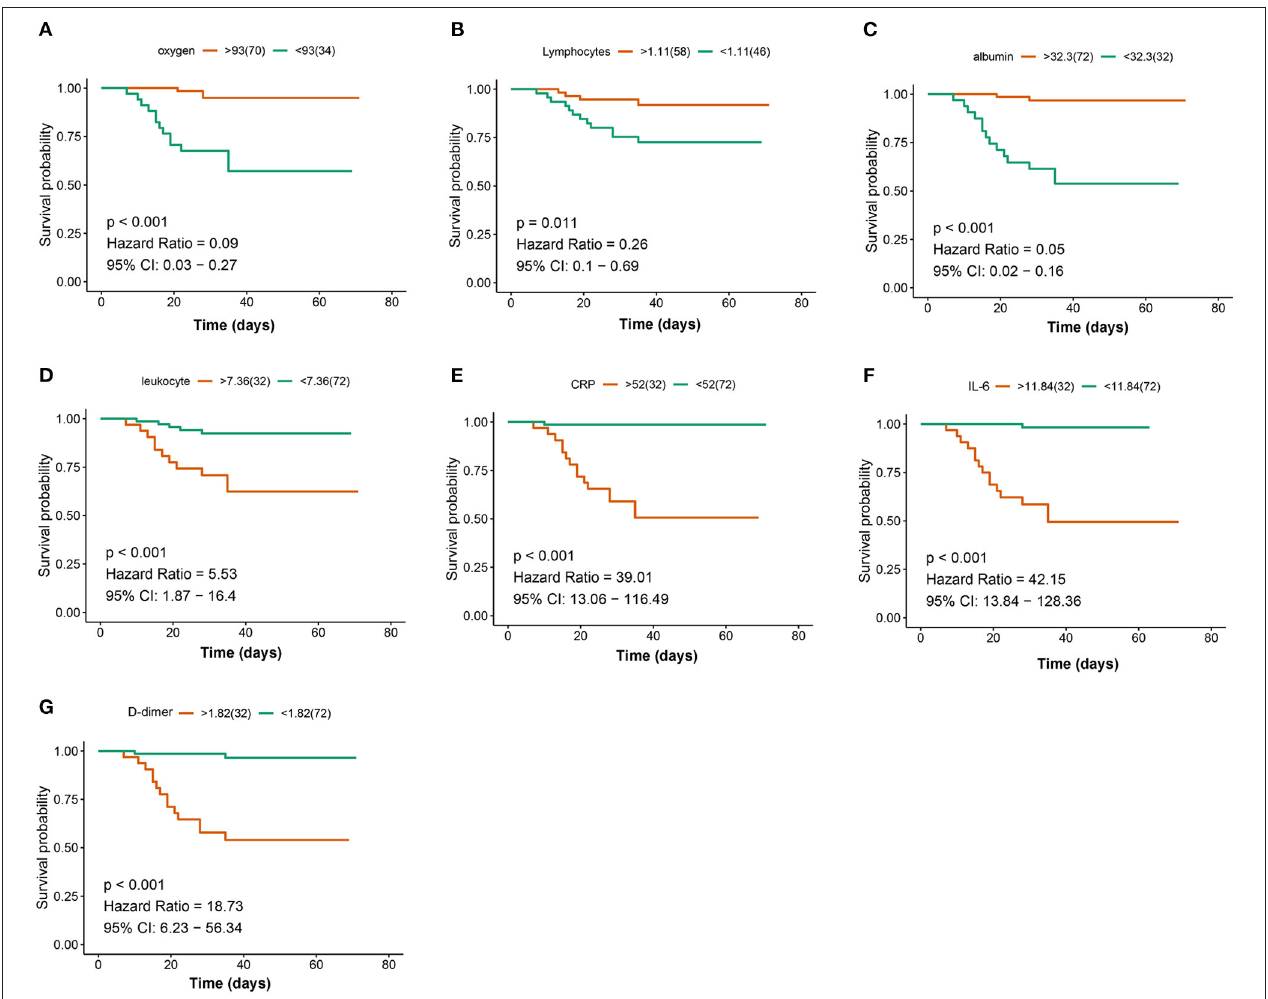
FIGURE 2 | Kaplan–Meier (K–M) curves analysis for the seven indicators: oxygen (A) , lymphocytes (B) , albumin (C) , leukocyte (D) , C-reactive protein (CRP) (E) , interleukin-6 (IL-6) (F) , and D-dimer (G)